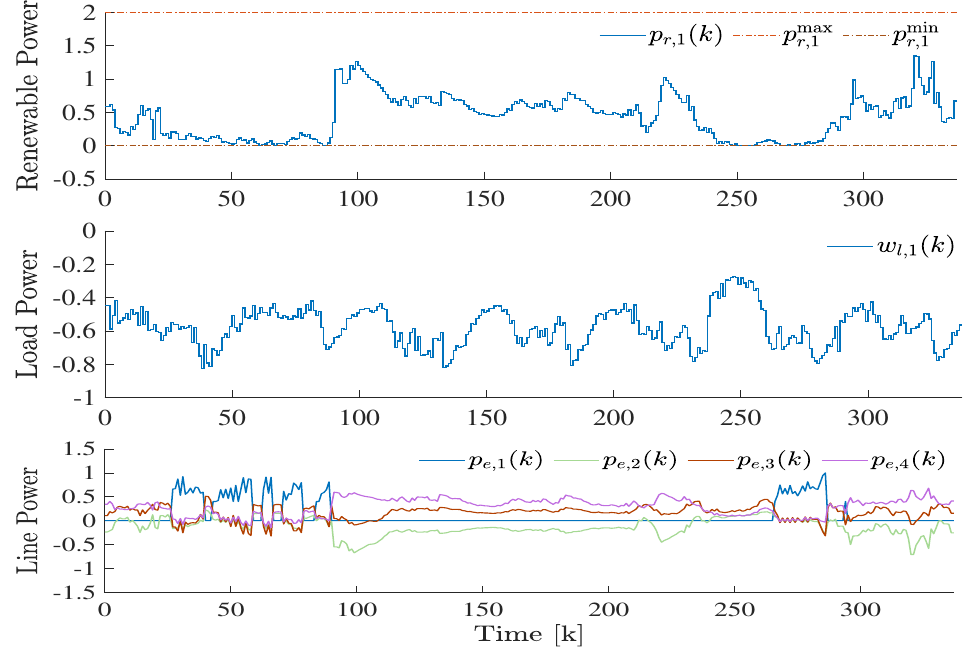
Figure 5. Power of units and